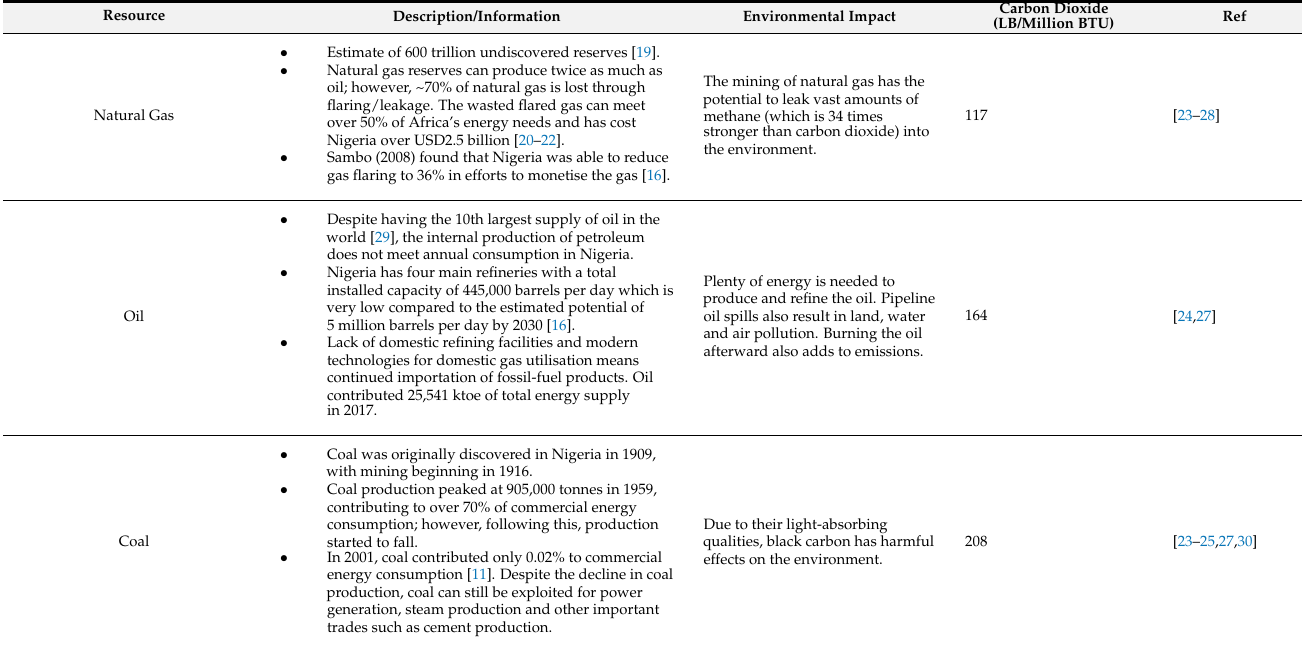
Table 2. Environmental Impacts of Fossil Fuels In